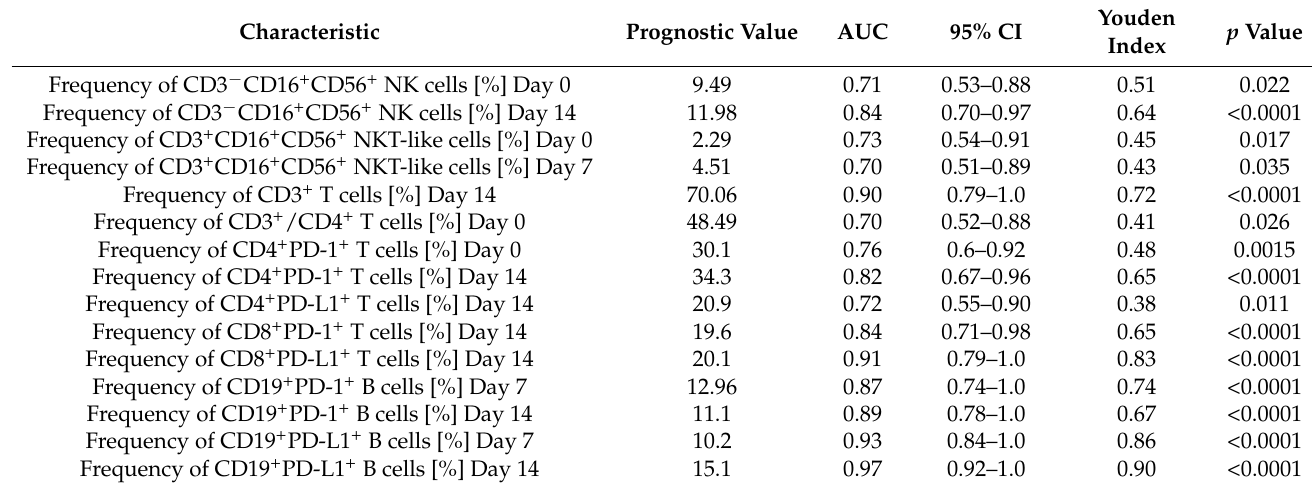
Table 6. Receiver operating characteristic (ROC) analysis of the diagnostic accuracy of lymphocyte subsets in the differentiation of patients with fatal